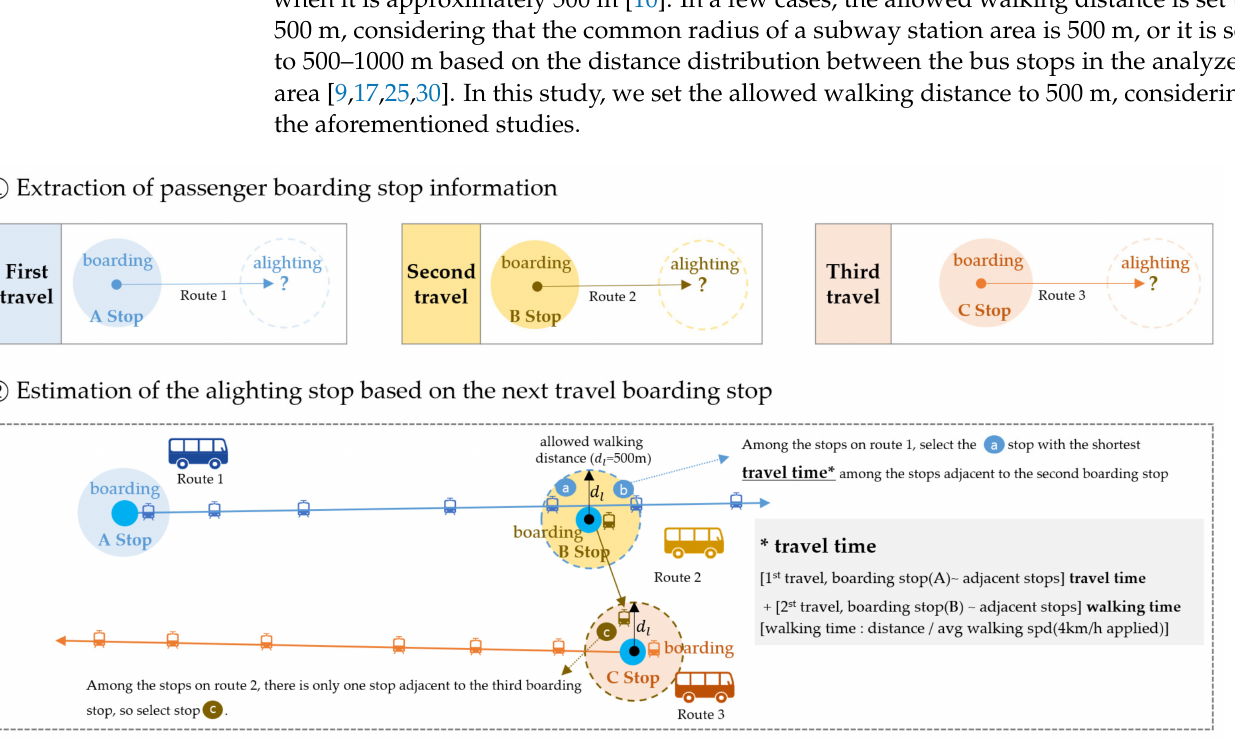
Figure 2. Method of estimating the alighting stop for continuous